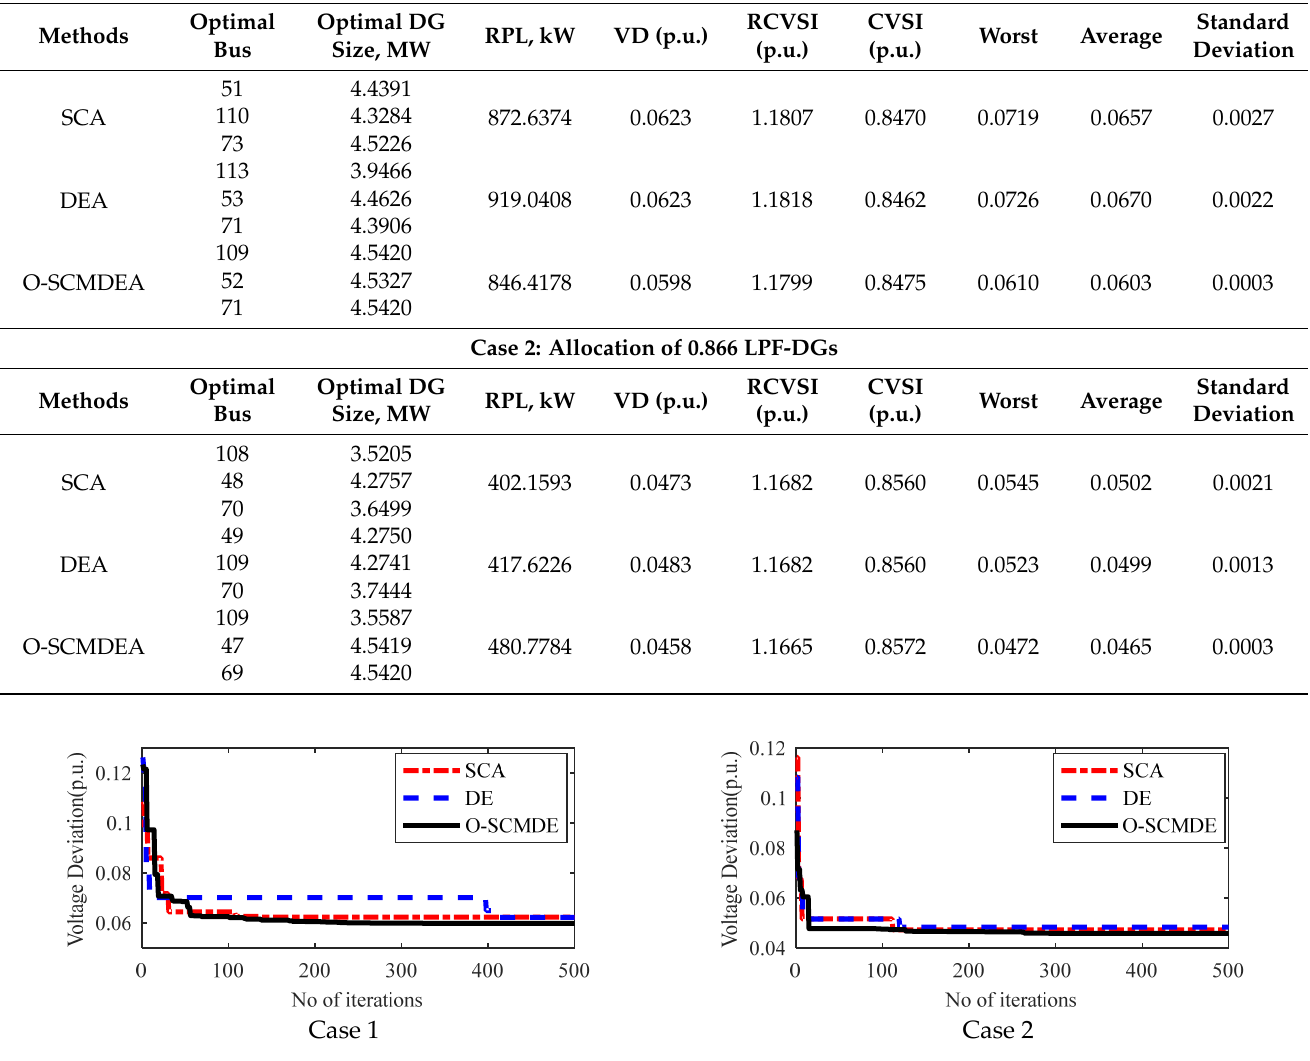
Table 9. Comparison of the results for the voltage deviation minimization of 118 bus DN. Case 1: Allocation of UPF-DGs